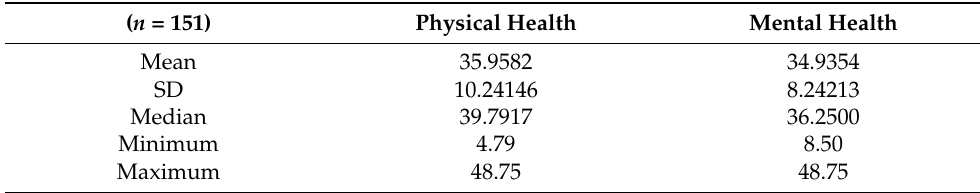
Table 3. Summary Scores of Total Patients in the Study